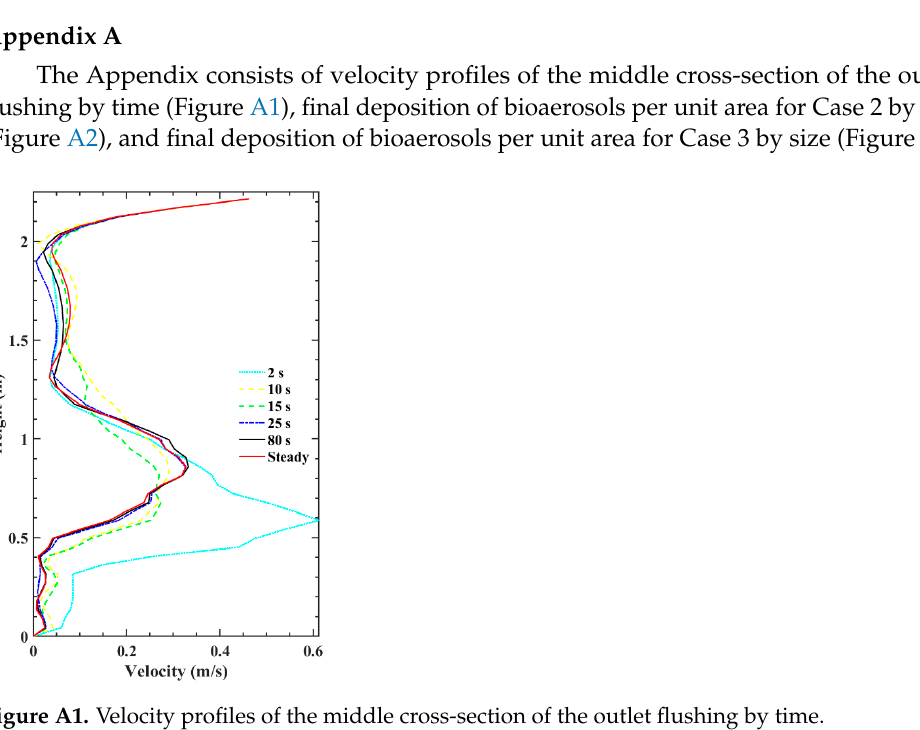
Figure A1. Velocity profiles of the middle cross-section of the outlet flushing by